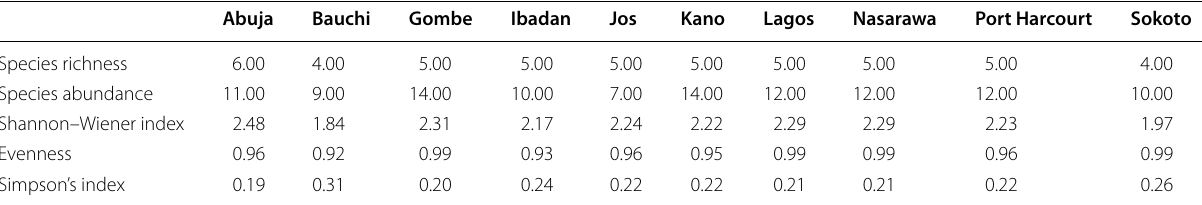
Table 3 Species richness, abundance, Shannon index, evenness and Simpson’s index of six indigenous entomopathogenic fungi isolated from the different geographical zones in Nigeria